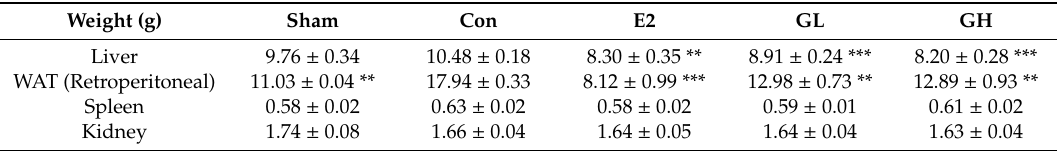
Table 3. Rats organelle weight.